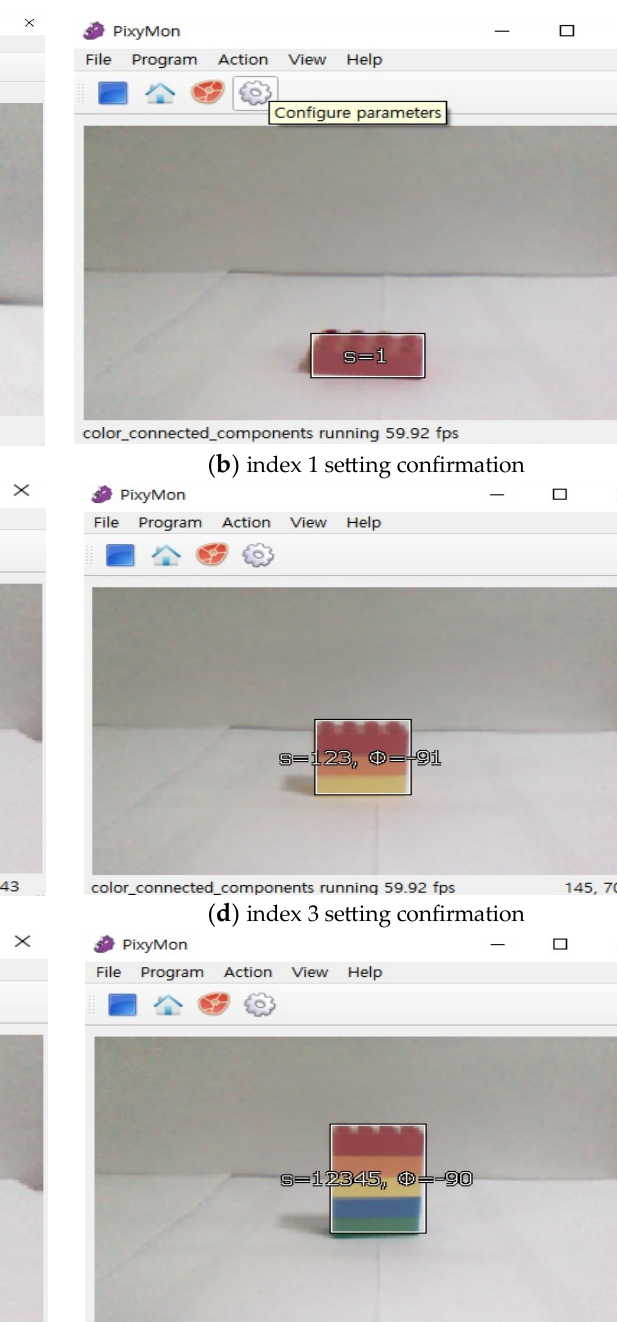
sensor. As shown in Figure 7, after indexing red in color 1, orange in color 2, yellow in color 3, blue in color 4, green in color 5, pink in color 6, and purple in color 7, it can be seen that adjacent blocks of seven colors are recognized as a single object.